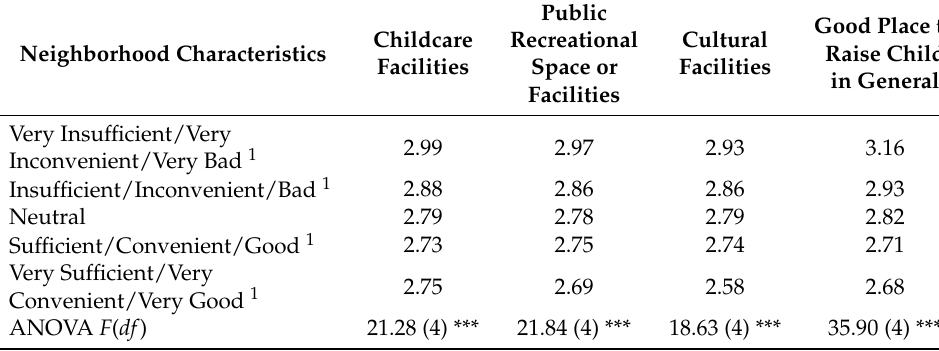
Neighborhood Characteristics